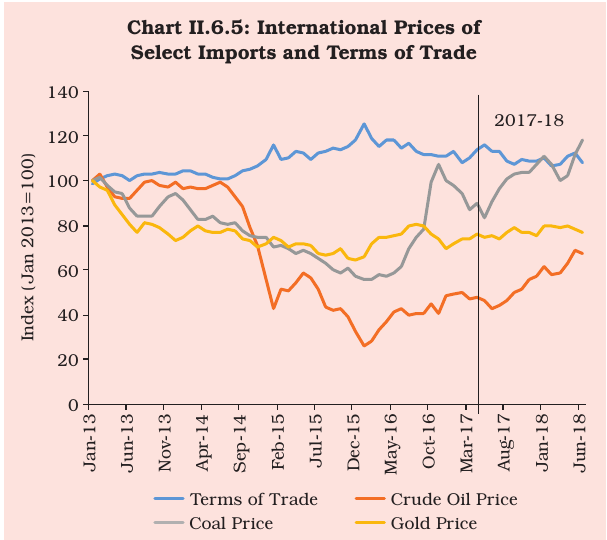
(PPAC), World GoldPetroleum Planning & Analysis Cell